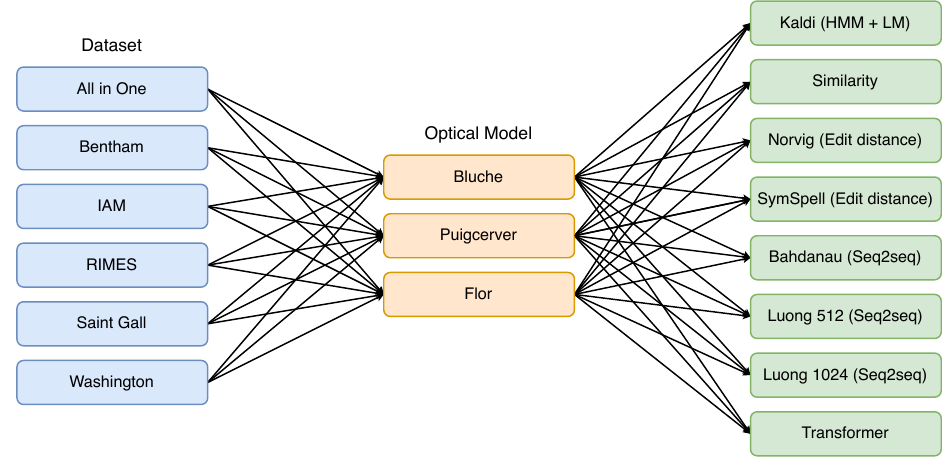
Figure 9. Experiment design